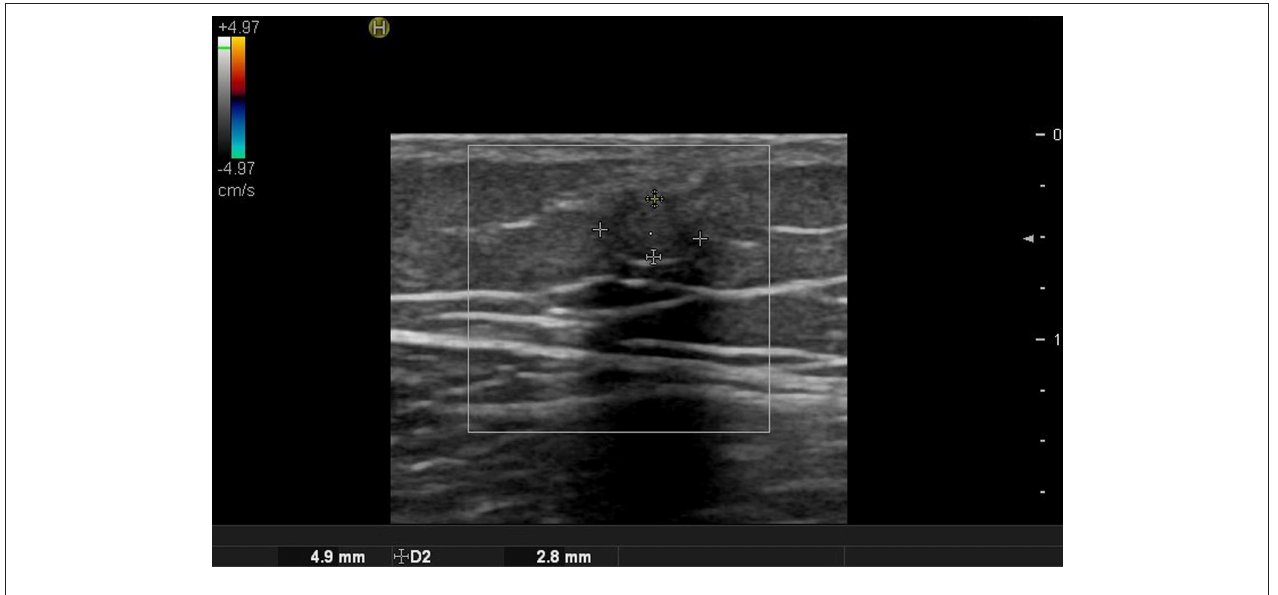
FIGURE 4 | Ultrasound image of pilomatricoma.